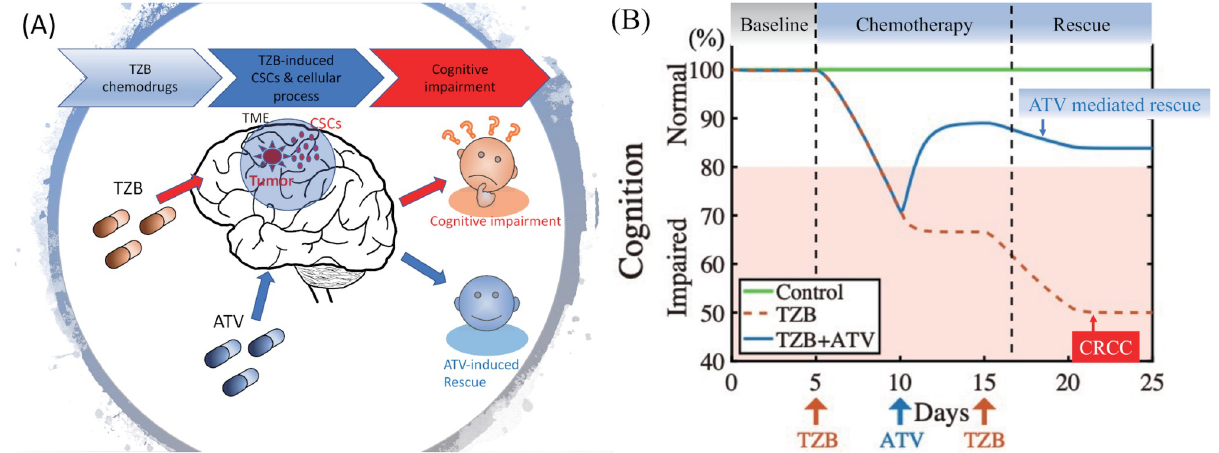
Fig 6. Effect of existing approved drugs, ATV, on cognitional activity in a combination cancer therapy. (A) Even though the current clinical therapy is to prescribe chemodrugs such as TZB to treat the growing tumor in tumor microenvironment (TME), a more aggressive, targeted combination approach is to prescribe existing other drugs, such as ATV, that improves the cognition level and normalize likely convergent cellular networks. (B) With the combination therapy (TZB+ATV), we can aim to directly improve the temporal trajectory of CRCC and to suppress tumor growth, through suppression of IL-6 and recovering apoptosis of cancer cells after chemotherapy, returning cognitive capability to the normal level.